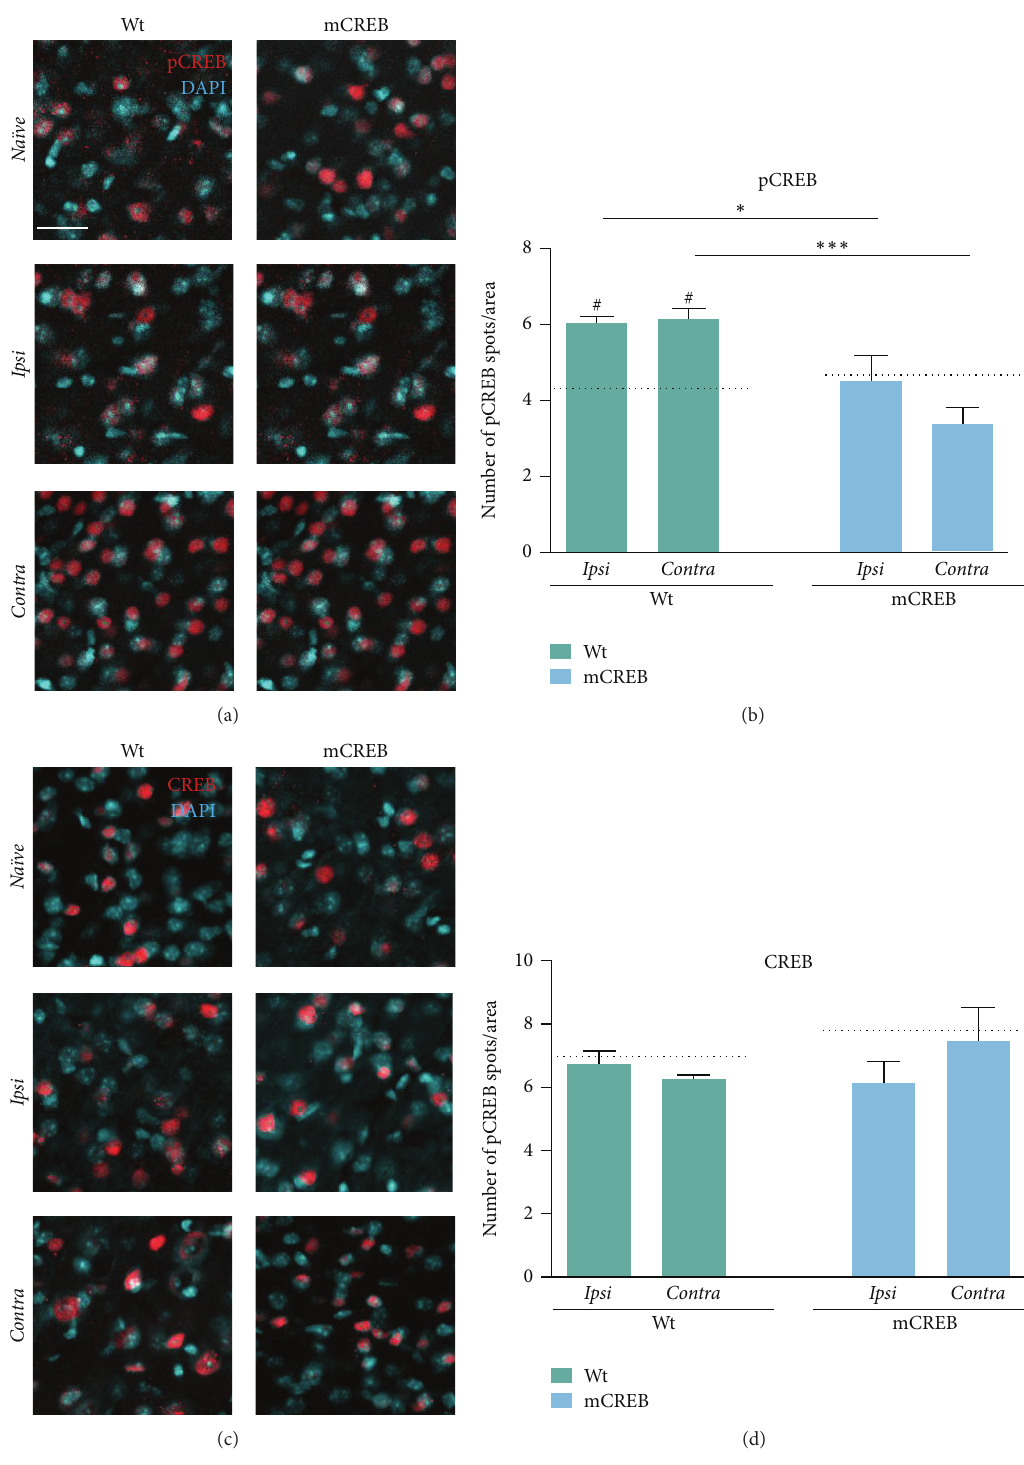
Figure 2: Whisker trimming associates with CREB phosphorylation in Contra and Ipsi barrel cortex without perturbing total CREB expres- sion. Representative images of (a) phosphorylated CREB (pCREB, red) and (c) total CREB (CREB, red) expression in immunofluorescence- stained barrel cortex sections. Sections were counterstained with DAPI (blue). Scale bar 30 𝜇 m. Histograms showing the average number of (b) pCREB and (d) total CREB positive spots per area from wild type (WT) and mCREB mice in Na¨ıve and trimmed condition ( Na¨ıve , Ipsi , and Contra ). Values are plotted as number of positive spots per ROI and expressed as mean ± s.e.m. Dotted lines indicate number of spots in barrel cortex of relative Na¨ıve control mice. # < 0.05 (difference from relative Na¨ıve controls); ∗ ∗ ∗ < 0.001; ∗ < 0.05 (difference between genotypes). 𝑁 : 4 to 6 hemispheres for each